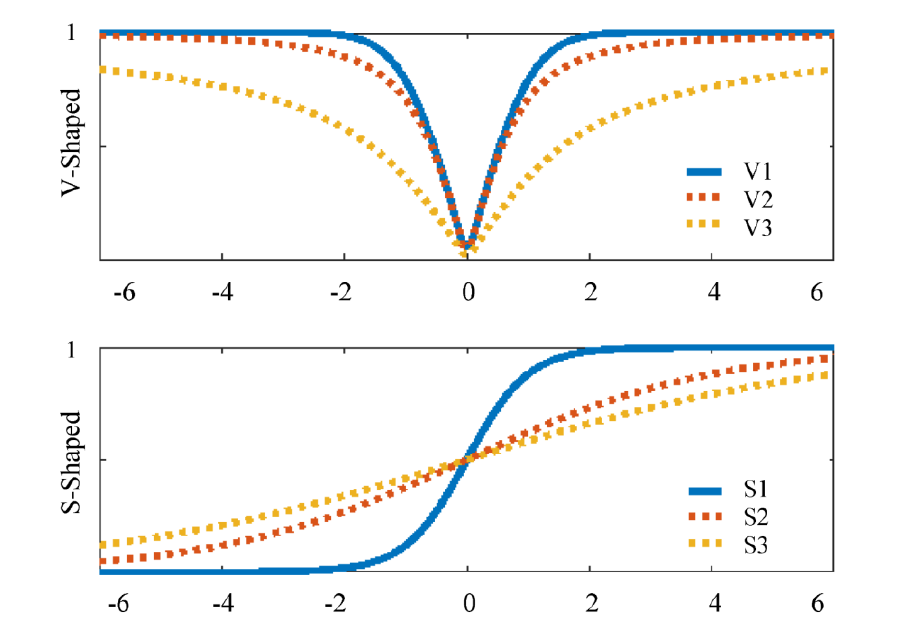
Figure 3. Transfer functions of V-shaped &